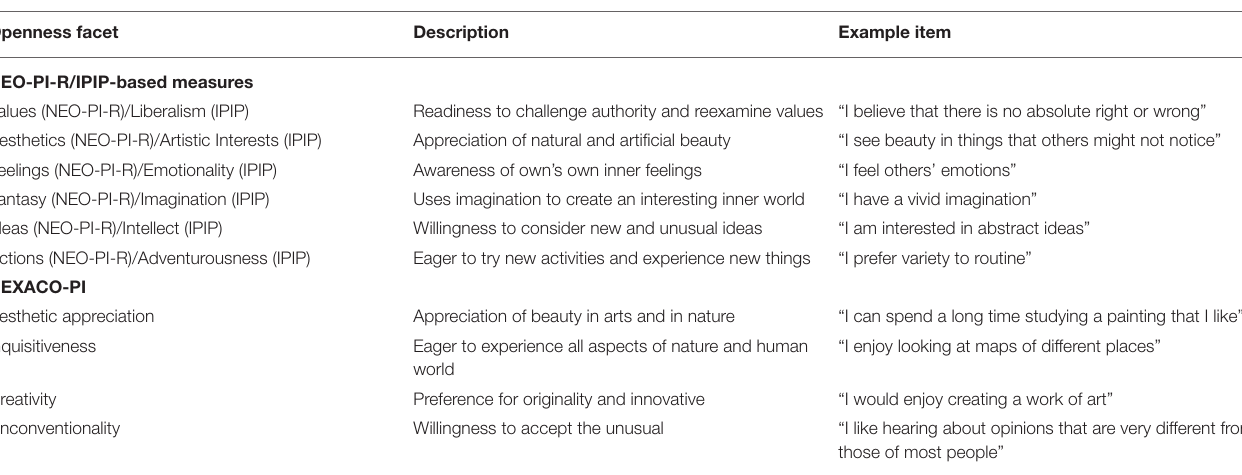
TABLE 1 | Definition of openness facets in NEO-PI-R, HEXACO-PI, and IPIP-based measures. Openness facet Description Example